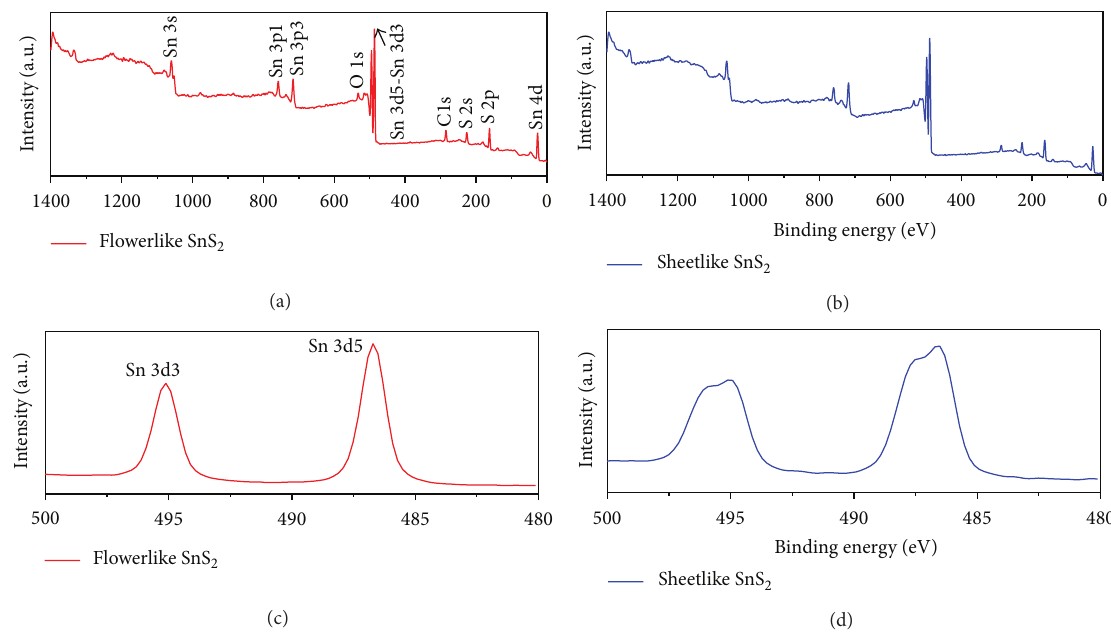
Figure 2: Wide range XPS survey profiles of the flowerlike SnS 2 (a) and sheetlike SnS 2 (b) and high-resolution spectra of Sn 3d in flowerlike SnS 2 (c) and sheetlike SnS 2